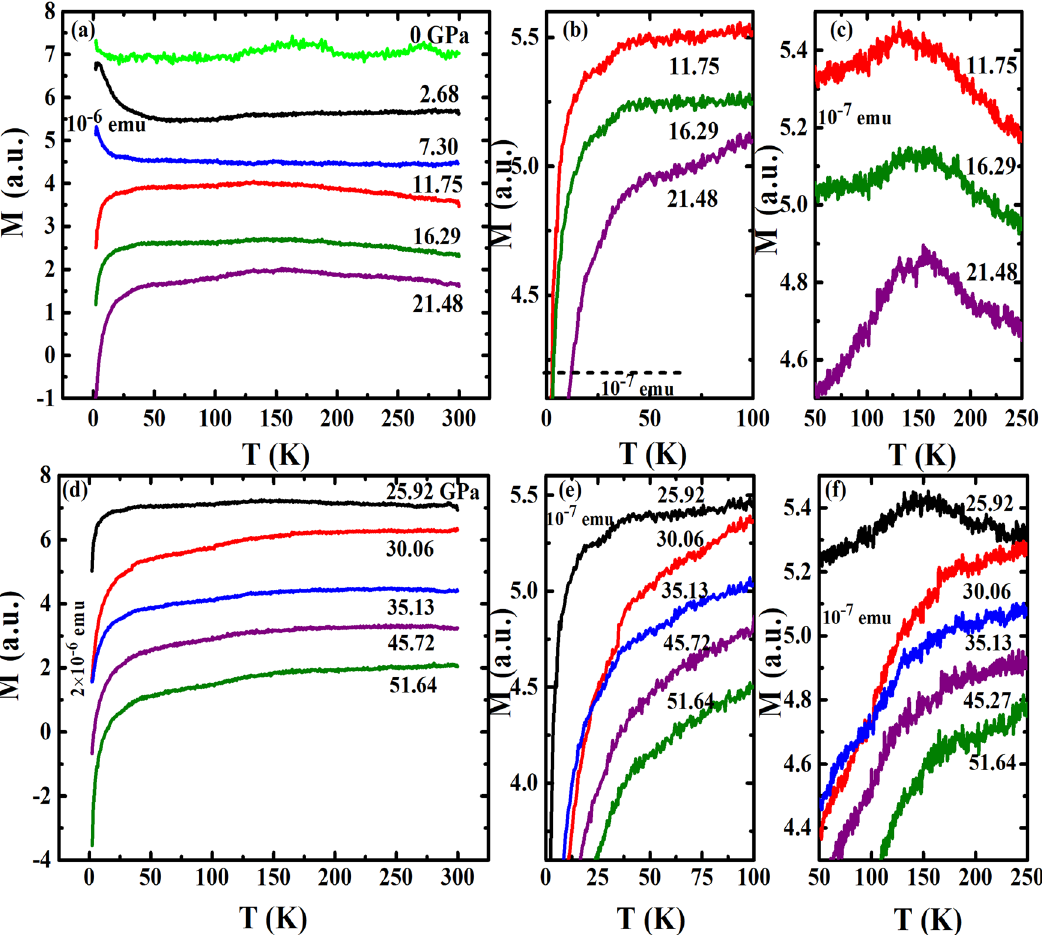
Fig. 2 Temperature-dependent magnetic moments of MnSe at different pressures. a – c M vs. T at different pressures up to 21.48 GPa. d – f M vs. T at different pressures between 25.92 and 51.64 GPa.